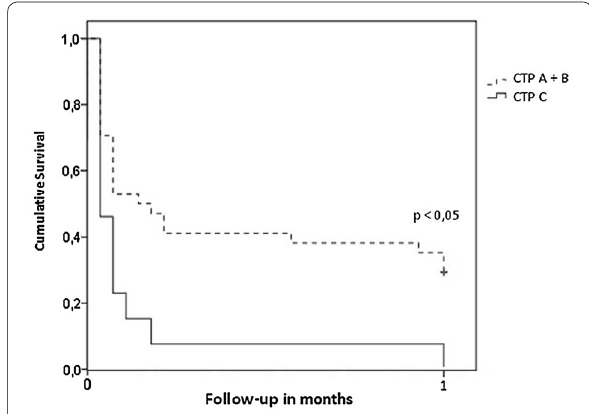
Fig. 2 Probability of having a good neurological outcome after a cardiac arrest among cirrhotic patients according to Child–Turcotte– Pugh score estimated by Kaplan–Meier